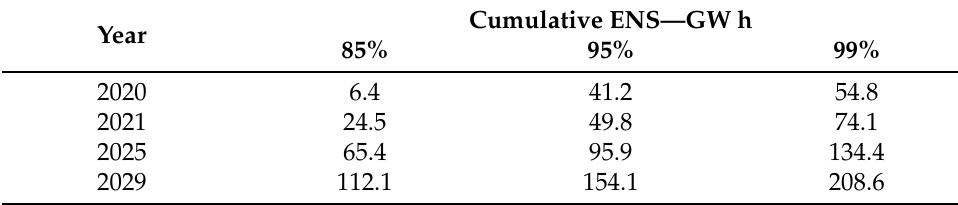
Figure 9. Cumulative probability of the expected energy not supplied by year. Table 4. Cumulative probability of the expected energy not supplied.